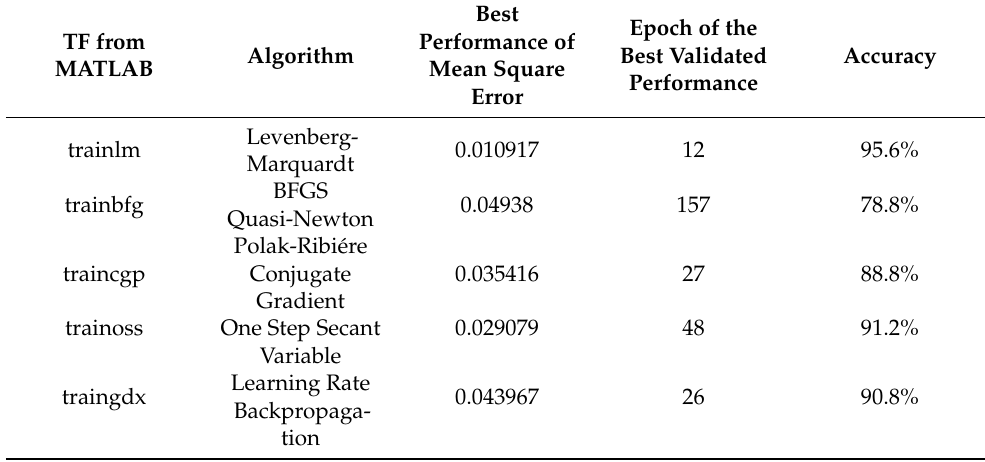
Table 2. Training characteristics and validation of results to be used in the